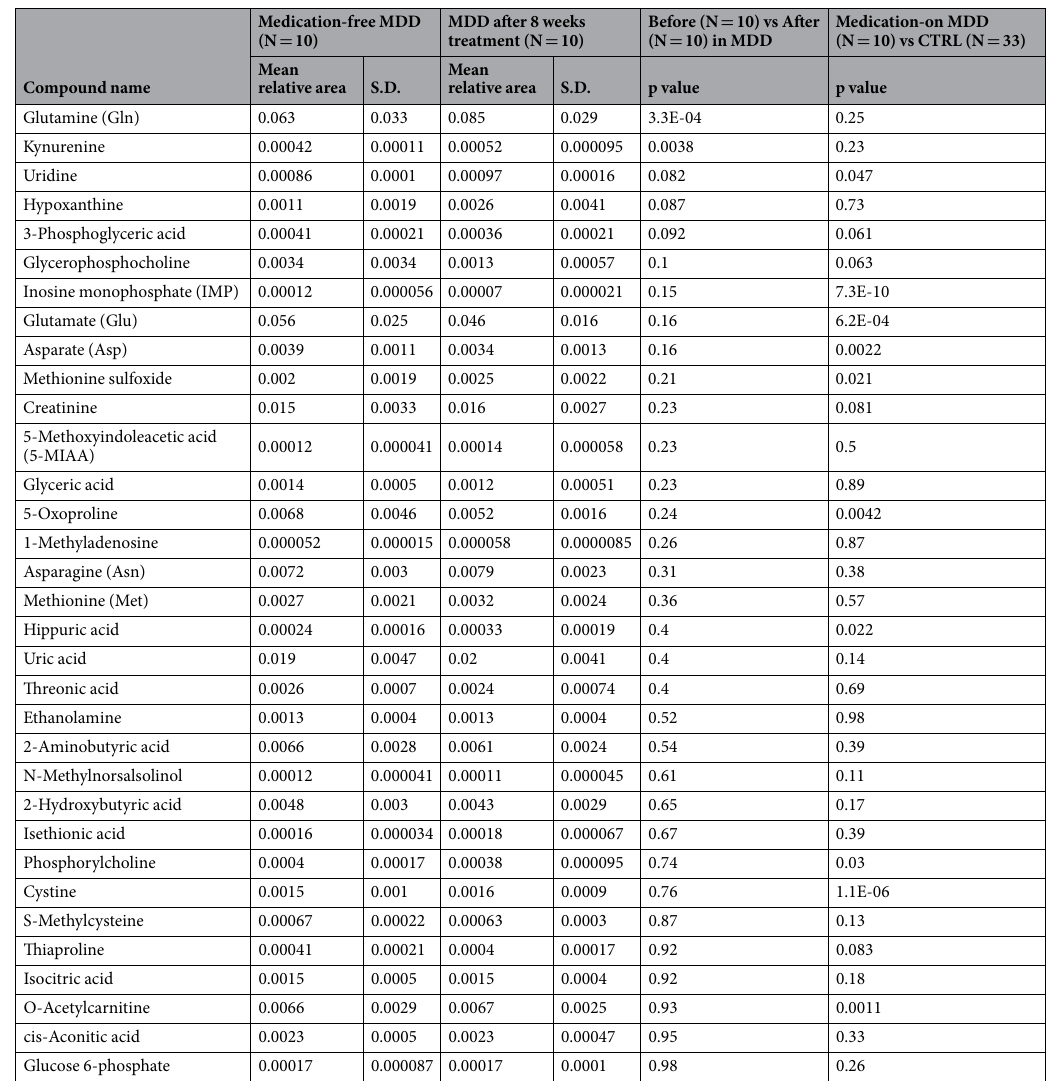
Table 4. The changes in metabolites in the MDD patients after 8 weeks of antidepressant